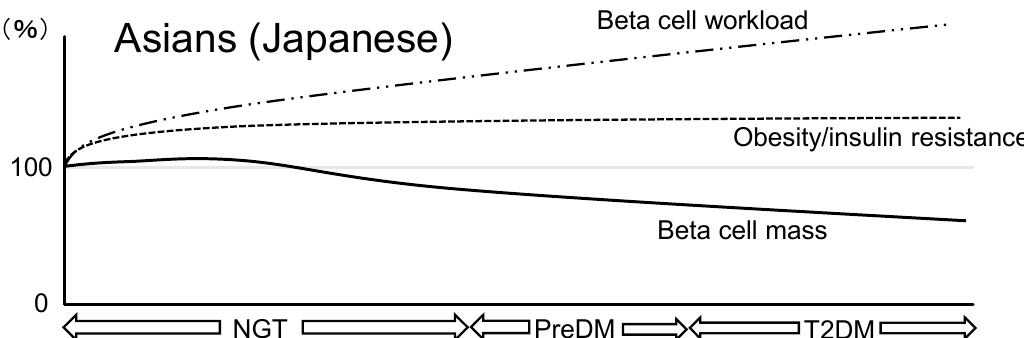
Figure 1. Hypothetical schema of different changes in beta cell mass in relation to obesity/insulin resistance and beta cell workload during the development of glucose intolerance in Caucasians and Asians (Japanese). NGT: normal glucose tolerance; PreDM: prediabetes; T2DM: type 2 diabetes. Beta cell mass increases to adapt to the increased demand in obese nondiabetic individuals in the Caucasian population, while beta cell mass expansion in the face of insulin resistance is extremely limited in Asians. Despite less obesity/insulin resistance, the limited increase in beta cell mass in Asians results in a similar increase in beta cell workload to that in Caucasians. Excess beta cell workload may eventually cause loss of beta cell mass. Once beta cell mass is reduced, beta cell workload will further increase, resulting in a vicious cycle. With progression to prediabetes and overt diabetes, progressive decline of beta cell mass underlies the disease.